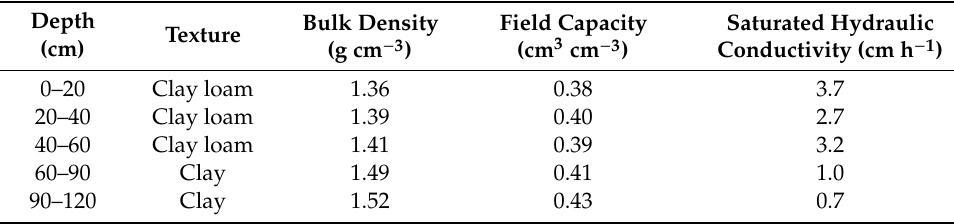
Table 1. Soil texture and hydraulic parameters at the